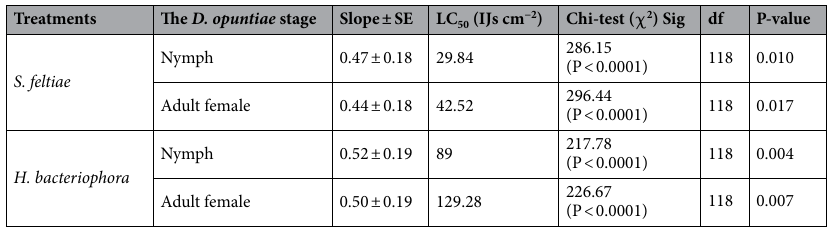
Table 1. Median lethal concentration LC 50 (IJs cm −2 ) of Dactylopius opuntiae treated by S. feltiae and H. bacteriophora (ANOVA, α =